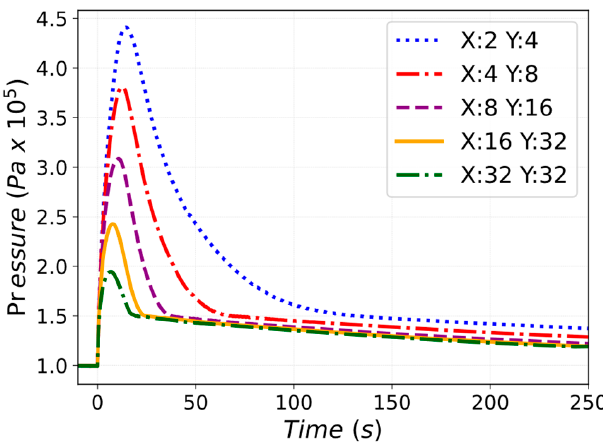
Figure 18. Pressure in the UPC for different numbers of relief panels.